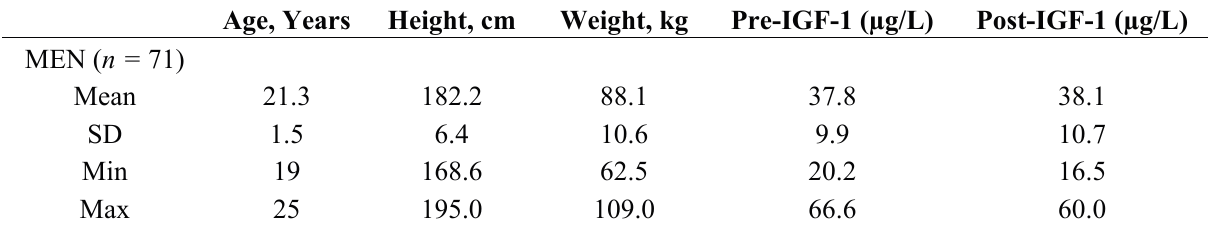
Table 1. Descriptive statistics for men.